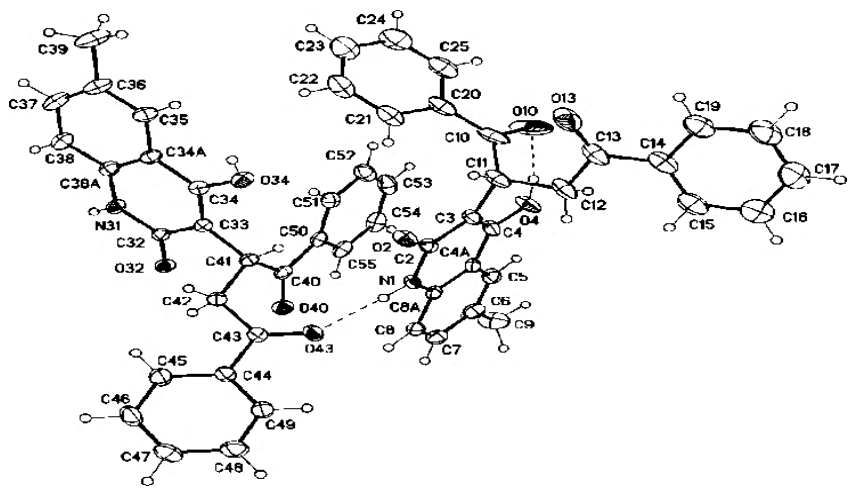
Figure 5. Molecular structure of the dimer of compound 6f.